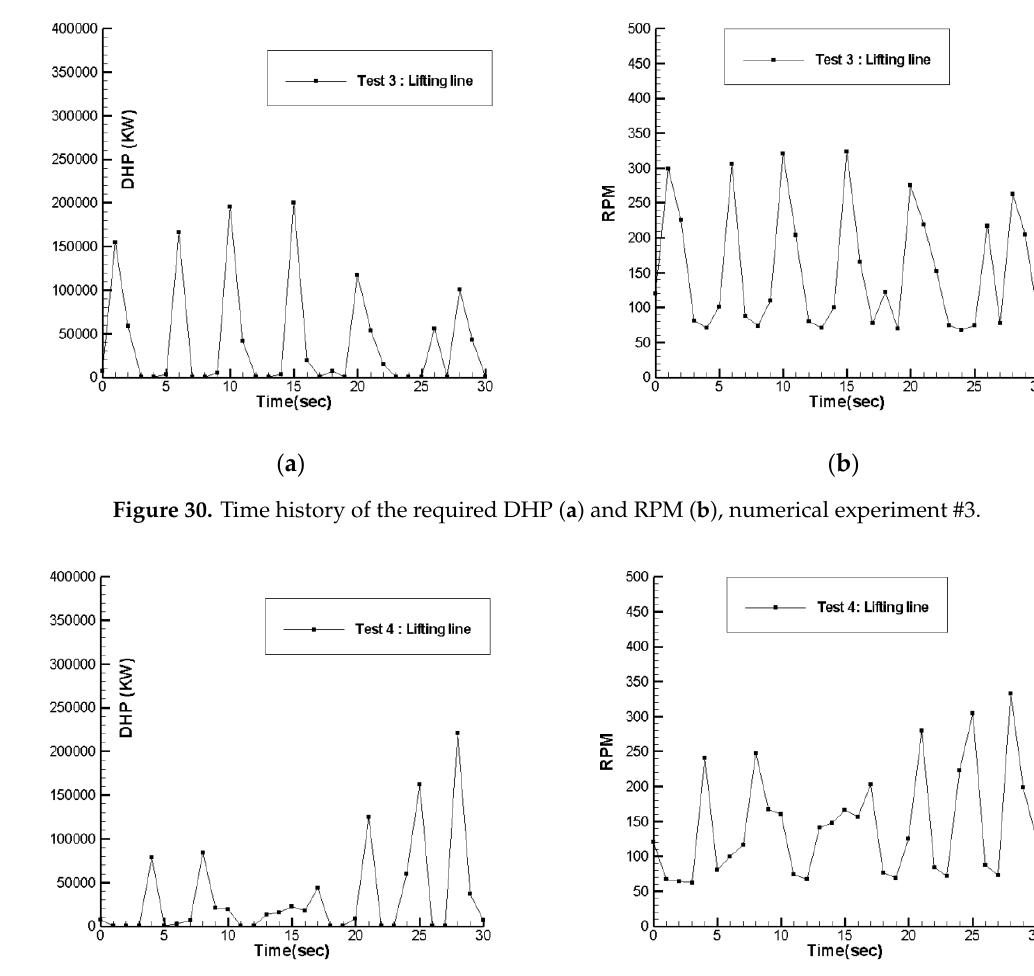
Figure 29. Time history of the required DHP ( a ) and RPM ( b ), numerical experiment #2.